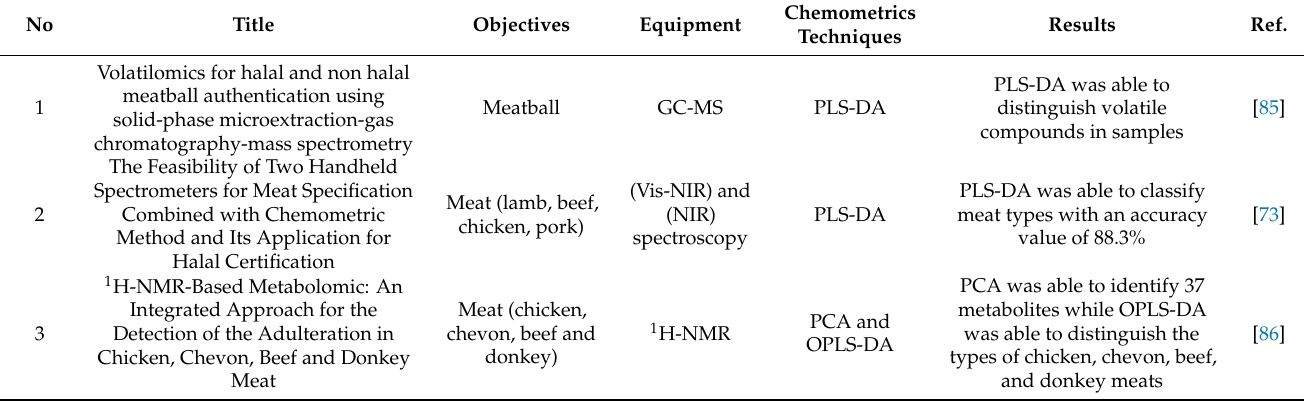
Table 1. Chemometric applications in metabolomic analysis for halal authentication of meat